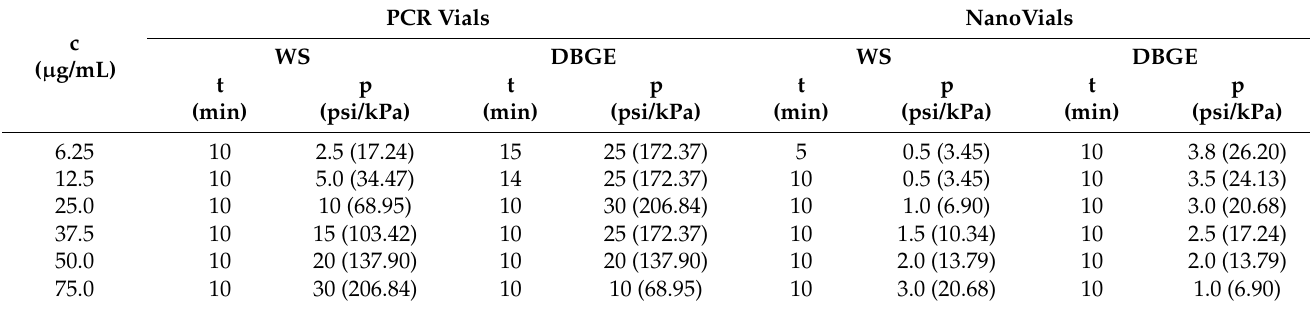
Table 1. Parameters for preparation of calibration solutions by CE instrument using PCR vials and SCIEX ® nanoVials. c ( µ